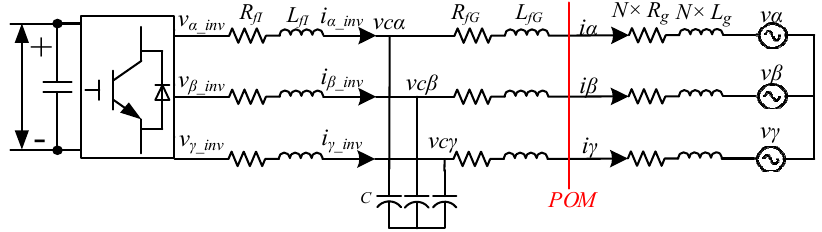
Figure 5. Equivalent circuit diagram of an IBR plant looking from the IBR side.